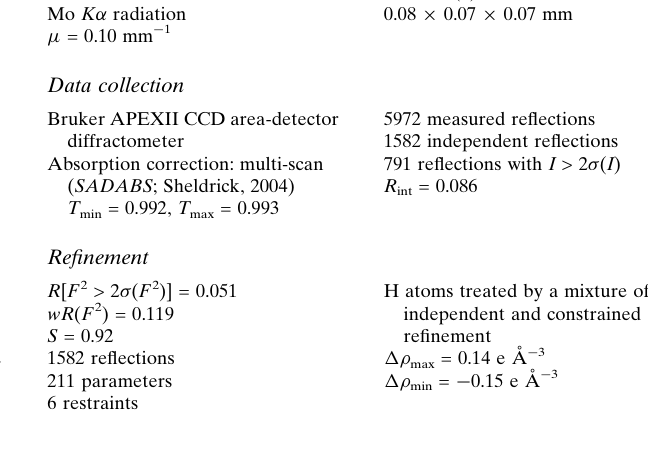
Data collection Bruker APEXII CCD area-detector diffractometer